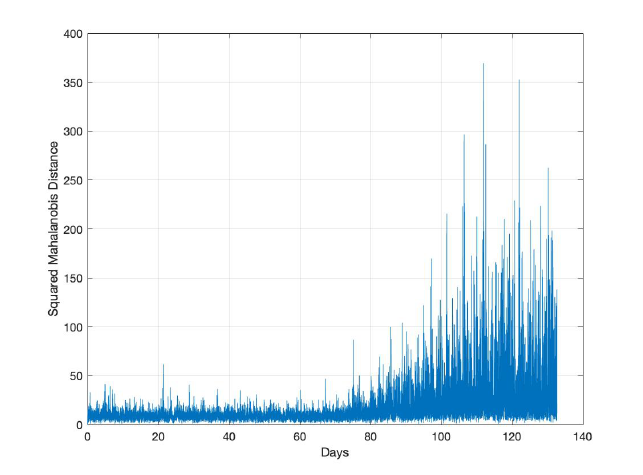
Figure 9. SMD for detecting an incipient